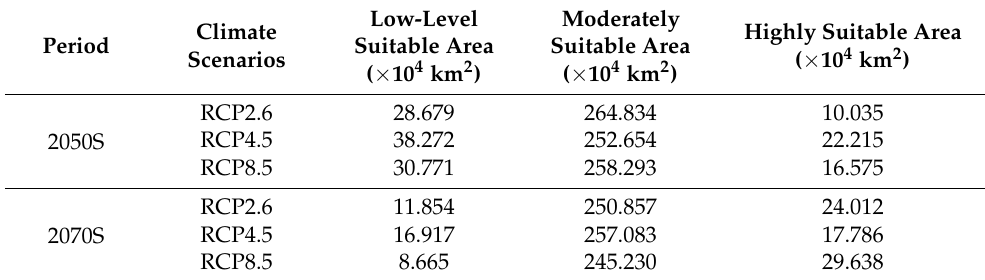
Table 4. Areas of potential distribution of Liriodendron chinense under different climate scenarios.